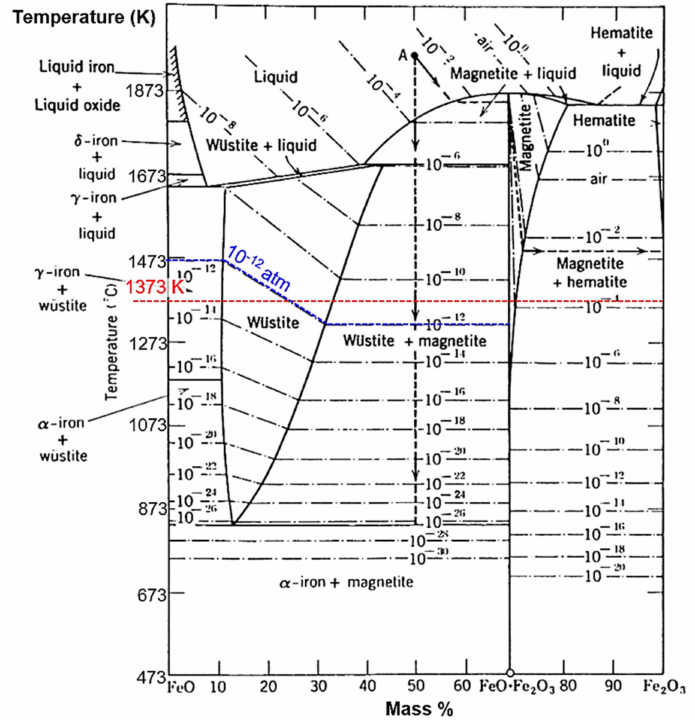
Figure 4. Phase diagram of FeO-Fe 2 O 3 system with oxygen pressure isobars. Reproduced with permission from [23], Elsevier, 1999.